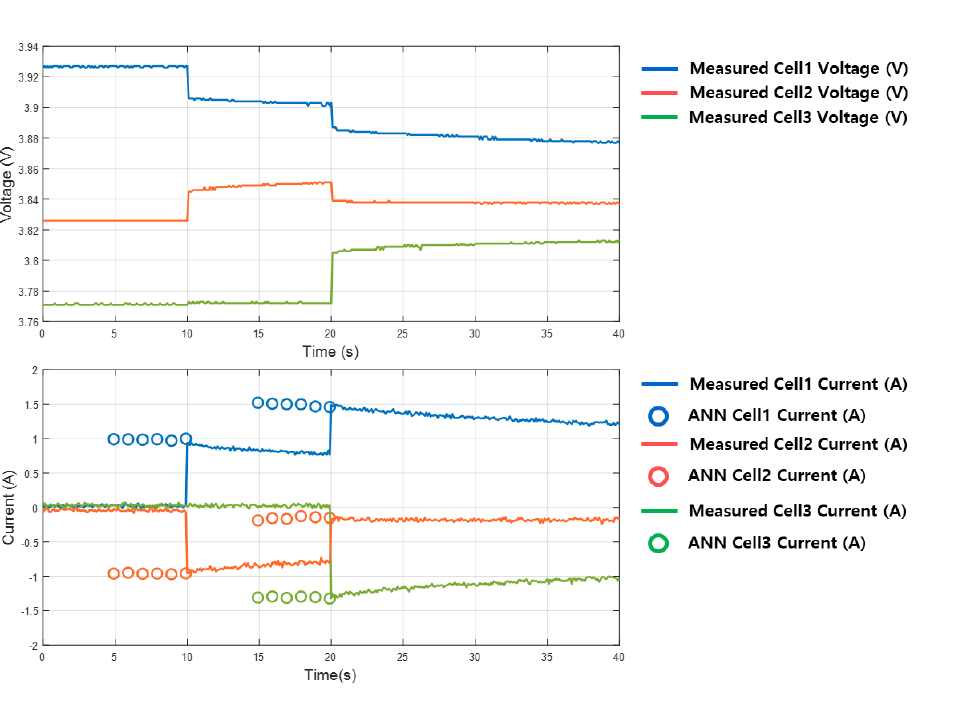
Figure 17. Experimental result of hot swap operation of three batteries with voltage deviation and simulation result of estimated circulating current of ANN model. Table 9. Comparison of peak current estimation results and experimental results during hot swap.